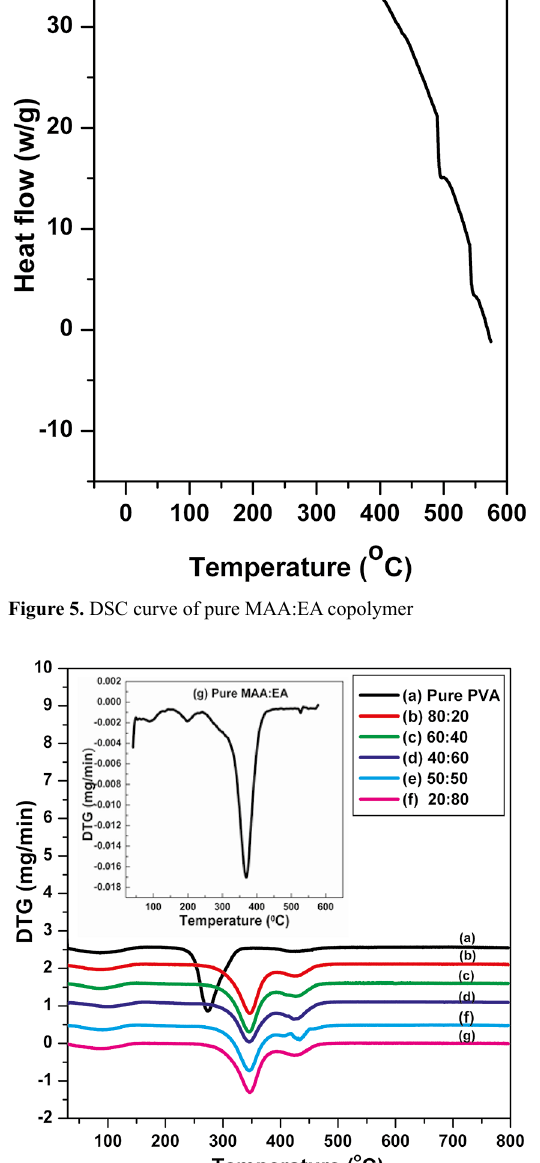
Figure 6. DTG curves of pure and blended PVA/MAA:EA samples (a) Pure PVA (b) 80:20 (c) 60:40 (d) 40:60 (e) 50:50 (f) 20:80